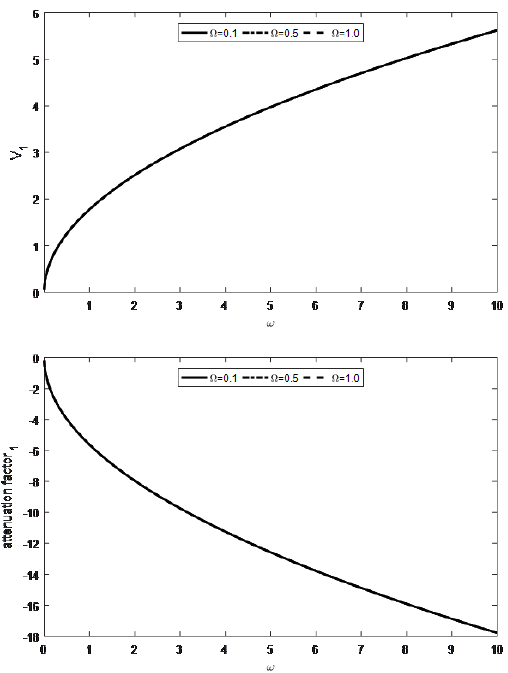
Figure 10: Velocity and attenuation factor for different values of ω and rotational frequency